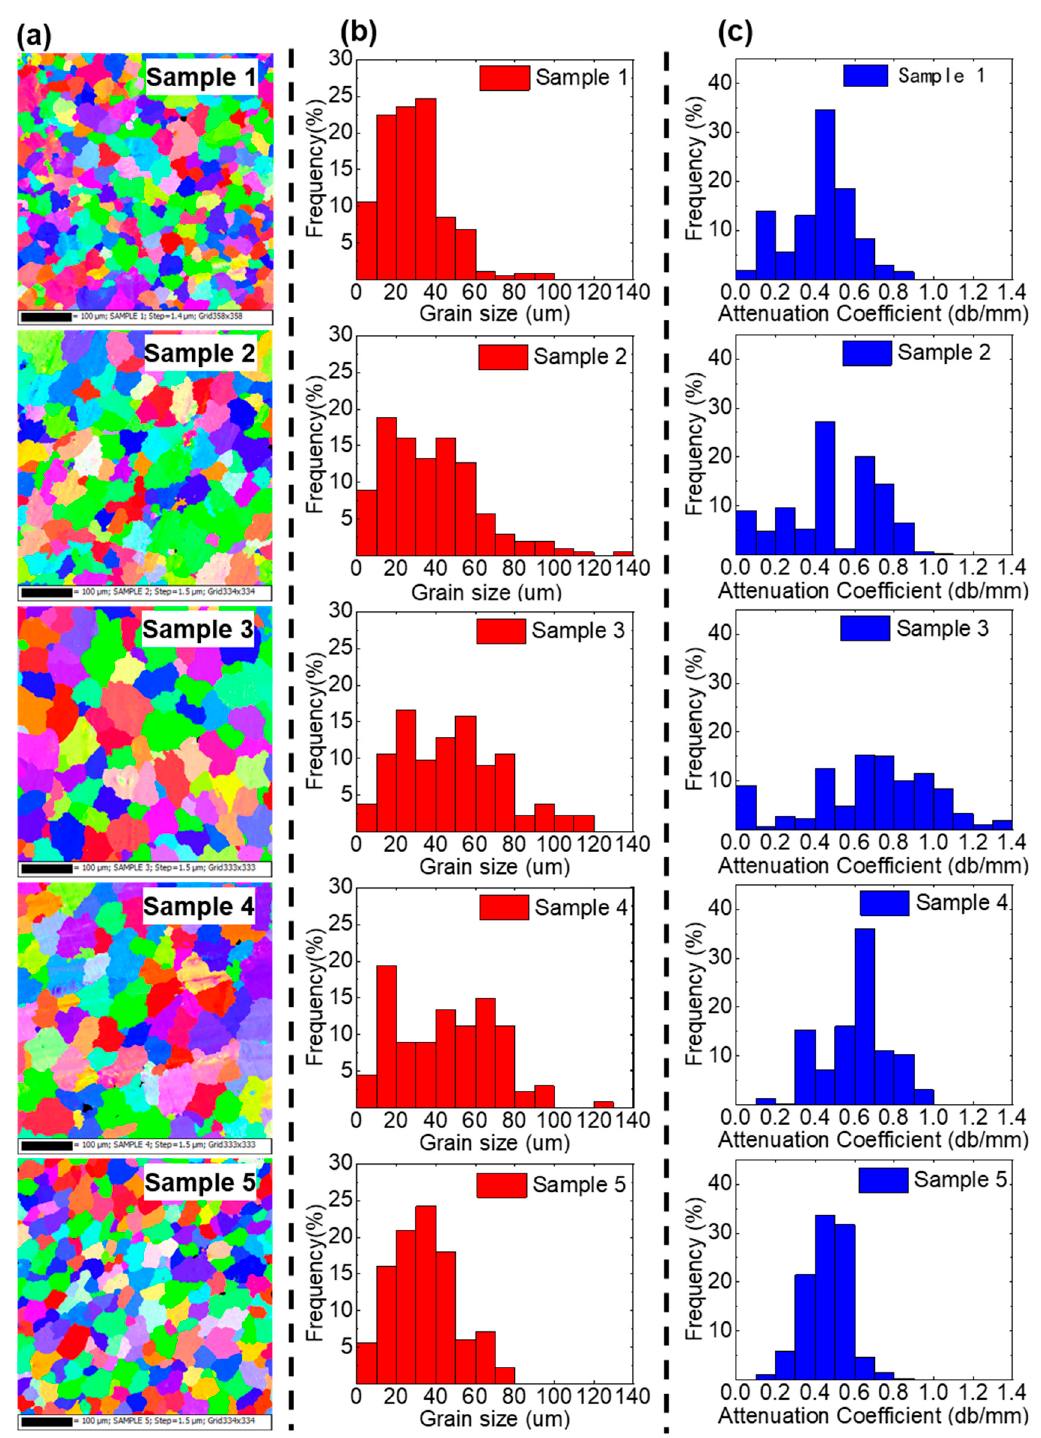
Figure 4. The measurements of grain size using EBSD and LOUD. ( a ) The EBSD maps of Samples 1–5 showing the grain size distribution. ( b ) The grain size measurements from the EBSD maps. ( c ) The distributions of grain size determined from the acoustic attenuation coefficient by LOUD for Samples 1–5, presented as blue histograms.